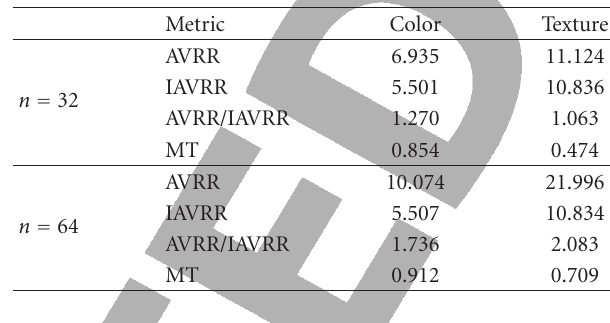
Table 2: Average query results for twenty test queries by color and texture, with n = 32 and n =